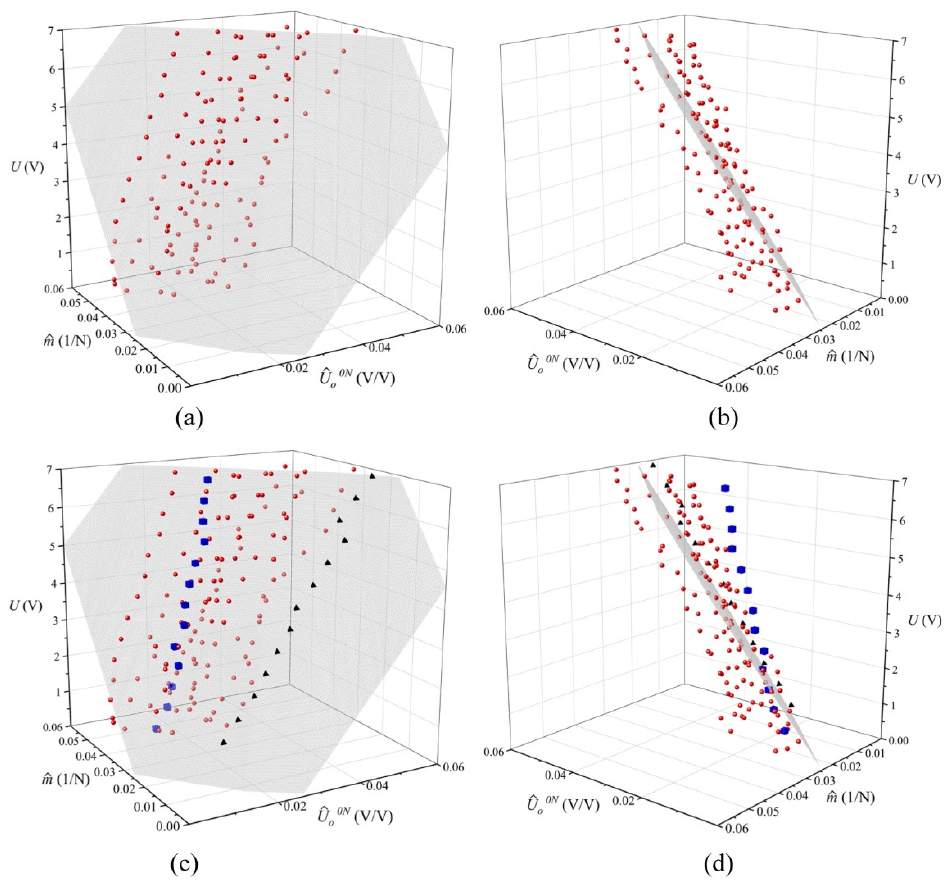
Figure 6. 3D plot of the normalized sensitivity ( ˆ m ), the normalized output voltage at null force ( ˆ U o0N ), and the input voltage ( U ). Data corresponding to the 12 sensors belonging to Region (A). ( a , b ) Isometric views of the 3D fit using Equation (8) as the model with parameters shown in Table 2. ( c , d ) Isometric views of the 3D fit with special markers. The blue cubes and black pyramid markers correspond to individual sensors that shift in different directions along the plane when U is changed.